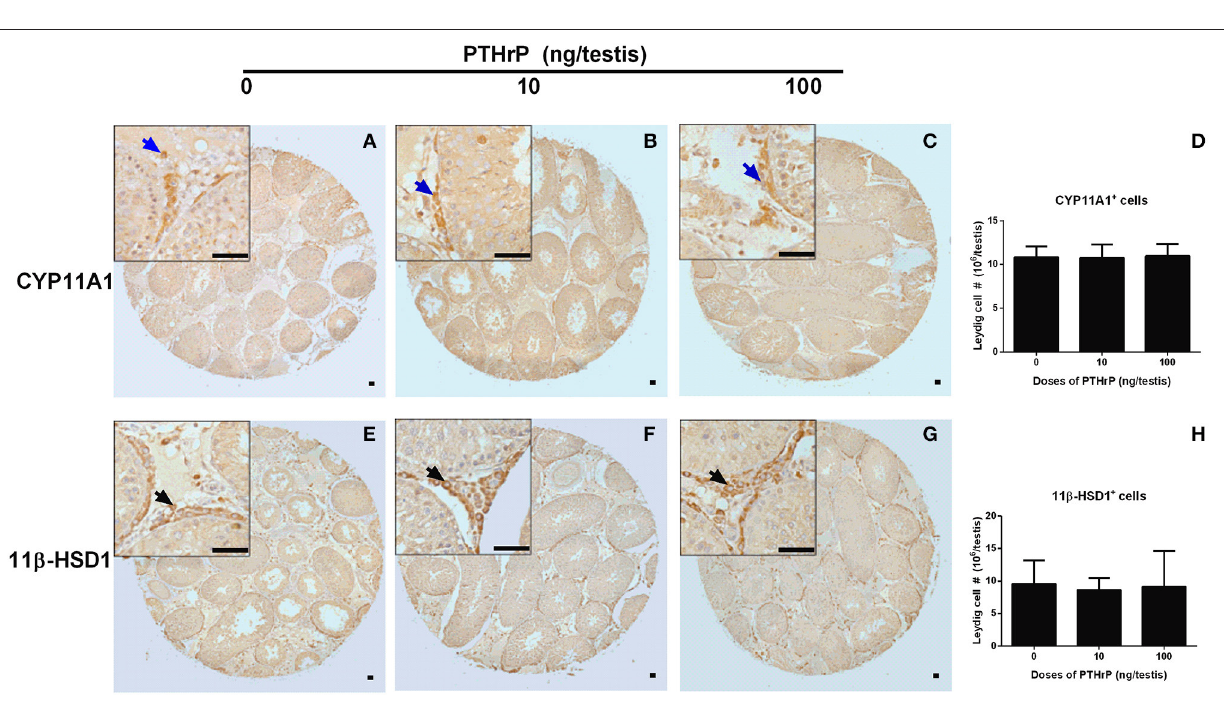
FIGURE 6 | Morphology of Leydig cells in the testes after in vivo PTHrP treatment. Immunohistochemical staining of CYP11A1 (A–D) and 11 β -HSD1 (E–H) of the testes from the rats treated with 0, 10, and 100 ng/testis PTHrP on post-EDS day 7 for 21 days. (A,E) : the control (0 pmol/testis PTHrP); (B,F) : 10 ng/testis PTHrP; (C,G) : 100 ng/testis PTHrP; (D,H) : quantitative data. Blue arrow indicates CYP11A1 positive Leydig cells. Black arrow indicates 11 β -HSD1 positive Leydig cells. Bar = 50 µ m. Mean ± SEM, n = 6. No significant difference between PTHrP group and the control was